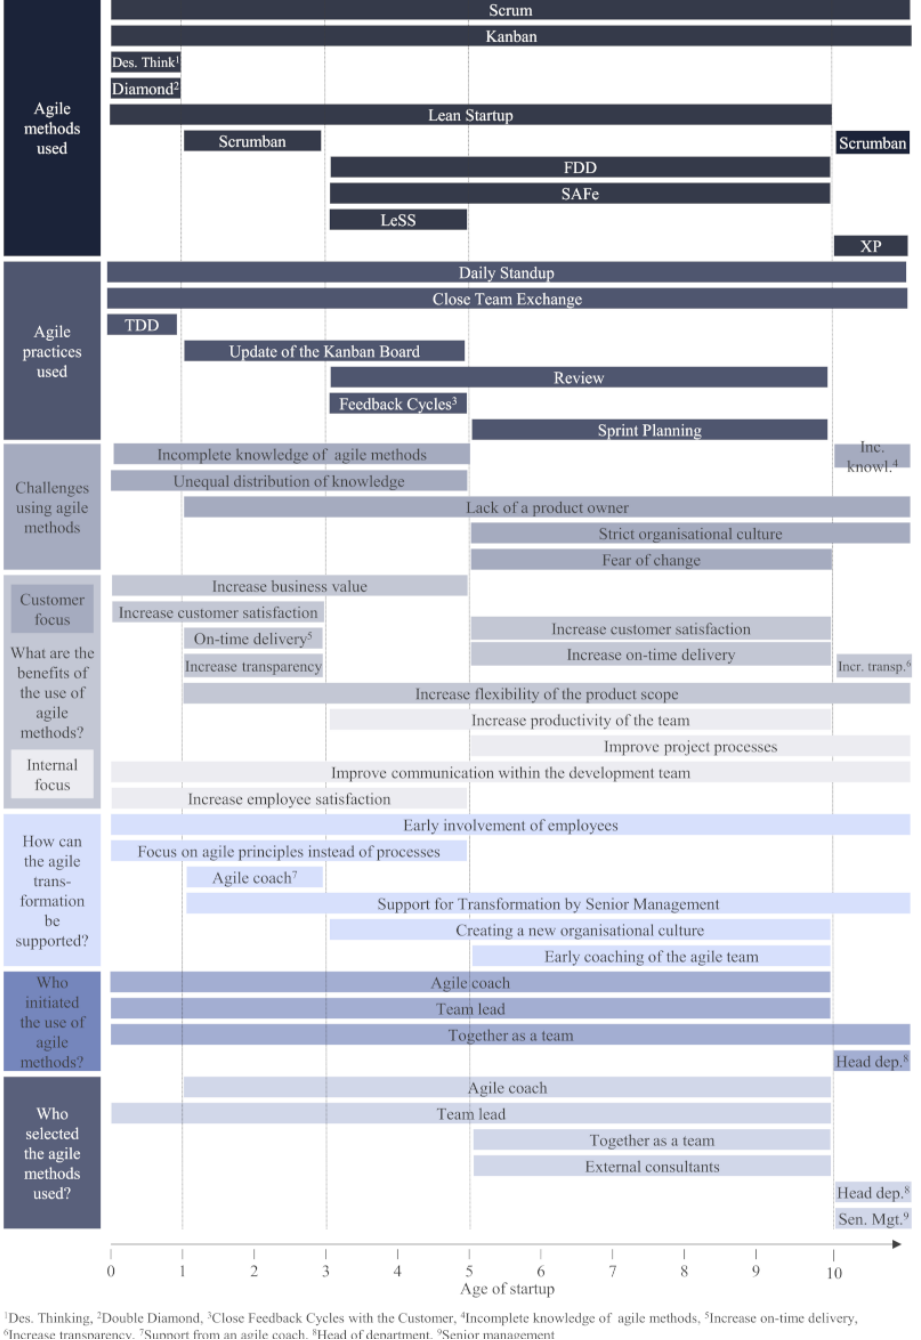
Figure 5. Framework on the use of agile methods and practices and the realised benefits and challenges in logistics